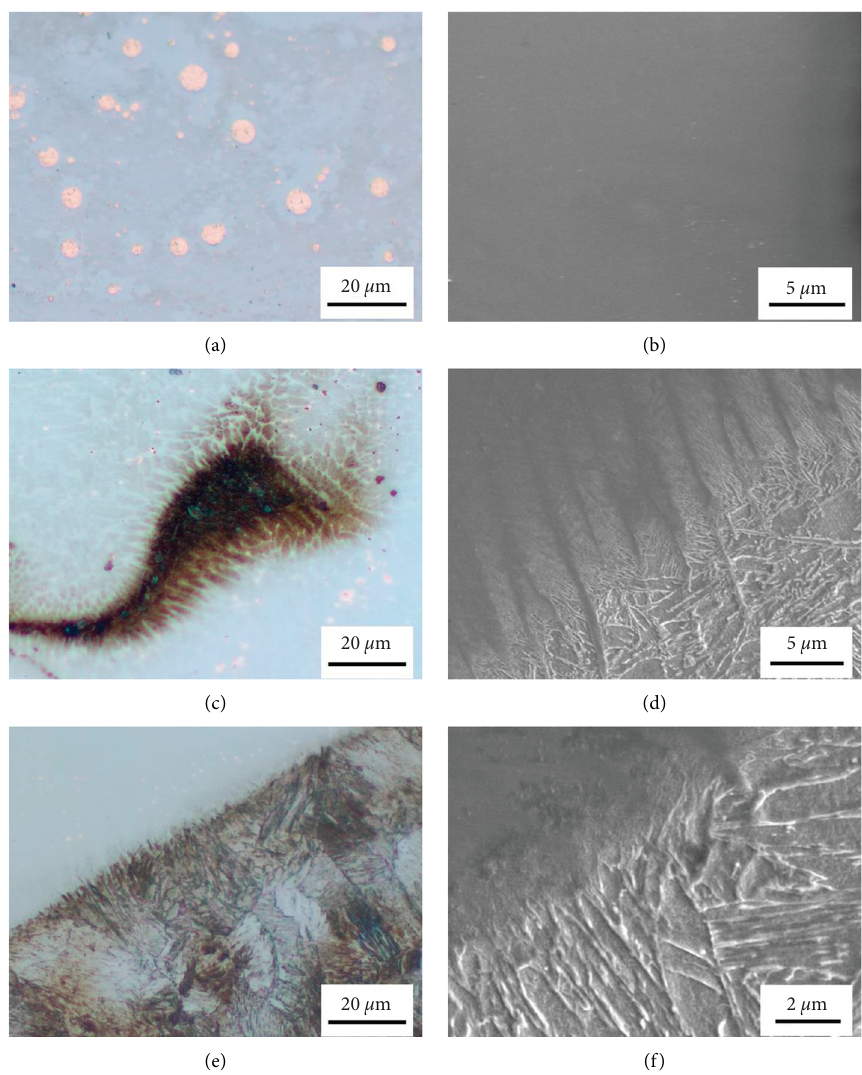
Figure 3: Cross-sectional enlargement images: (a, b) grey-white and golden phases; (c, d) black phase; (e, f) interface between the substrate and